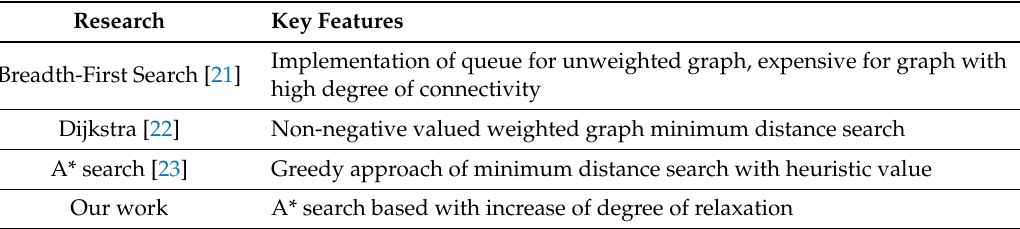
Table 3. Research on a minimum distance computation